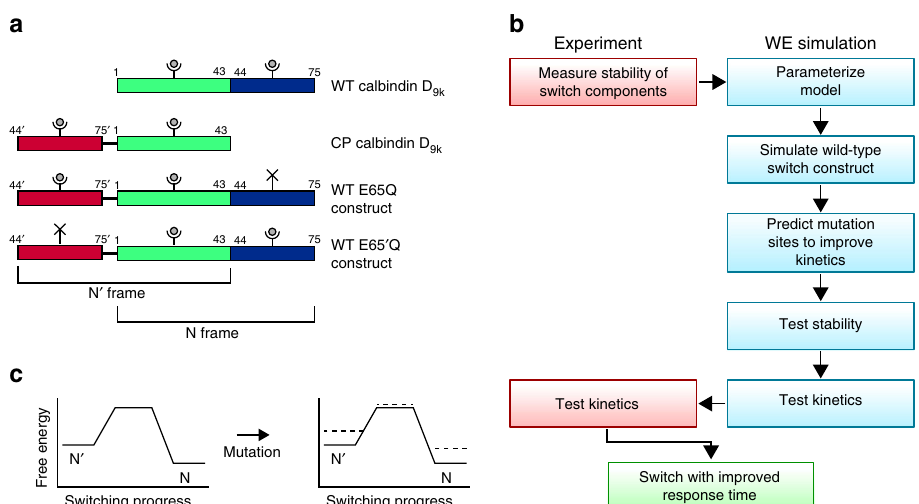
Fig. 1 Rational design strategy for improving the kinetics of protein conformational switching. a Alternate frame folding scheme for the calbindin-AFF construct. Green and blue bars represent the N-terminal and C-terminal EF-hands of calbindin D 9k , respectively, and ‘ Y ’ shapes represent calcium binding sites. Duplication of the blue region (residues 44 – 75) and appending this segment to the N-terminus of the protein via a six-residue linker creates two alternate frames for folding that correspond to WT and CP calbindin. Following a mutation that disrupts Ca 2 + -binding in one of the frames (indicated by a black ‘ X ’ ), the addition of Ca 2 + preferentially stabilizes the fold of the alternate frame. b , c The strategy for improving the response time of the switch involves b a close interplay of experiment and computation to c obtain preferential stabilization of non-native transient states relative to the ground states (N and N ′ ) (dashed lines), reducing the free-energy barrier for the switching process. Panel c depicts a schematic free-energy landscape for the E65 ′ Q construct in the presence of Ca 2 + ; the strategy is applied identically to the E65Q construct, which differs in that N ′ is more stable than N in the presence of Ca 2